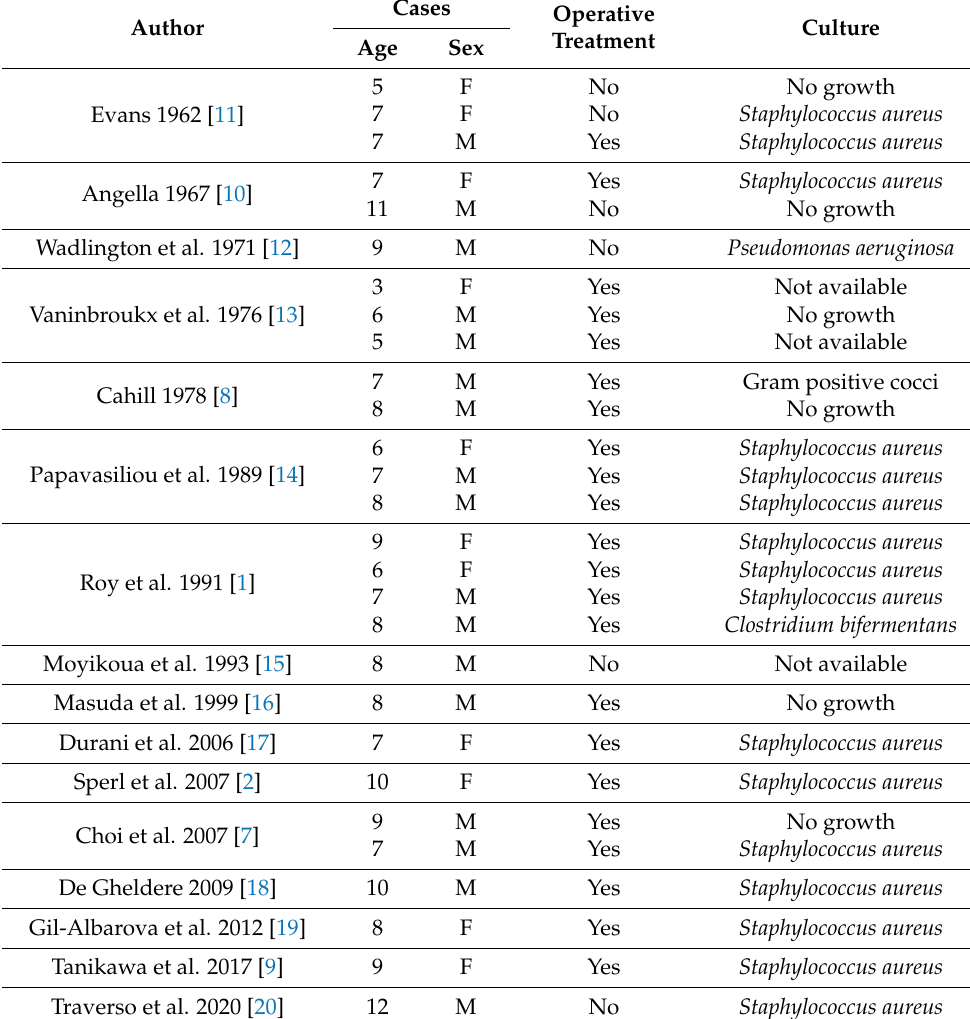
Table 2. Literature review for patellar osteomyelitis in